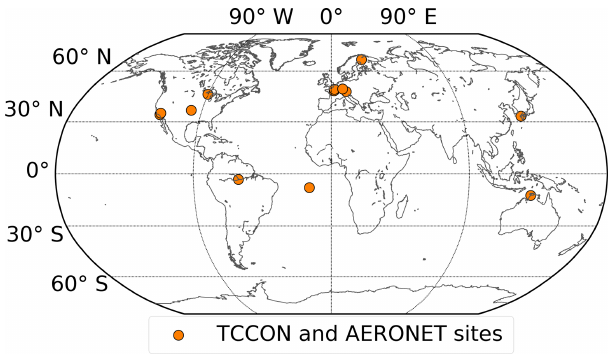
Figure 2. Validation locations used in this study. Every site con- tained both a TCCON and AERONET